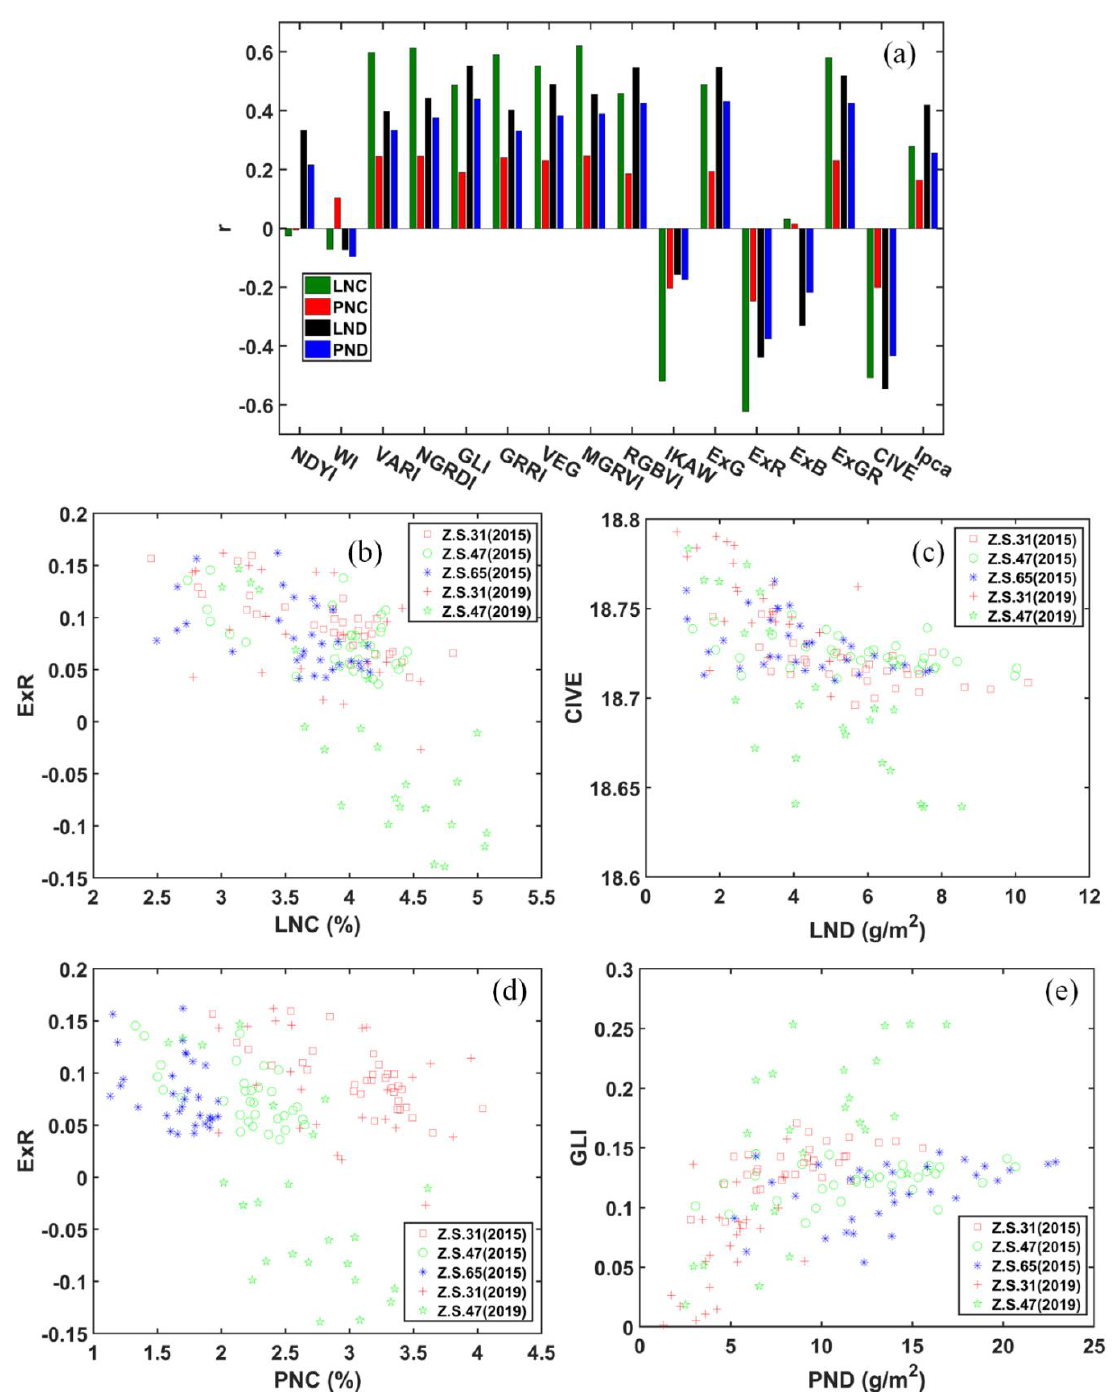
Figure 3. The responses of different RGB-based VIs to the four wheat N status indicators (i.e., LNC, PNC, LND, and PND) in the calibration dataset. ( a ) Pearson correlation analyses of RGB-based VIs and N status indicators, and ( b – e ) scatter plots of the best performing VIs and N status indicators for each growth stage.